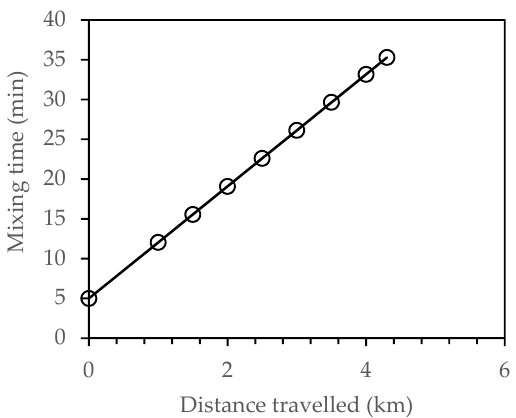
Figure 12. Effect of travel distance (between the backfill plant and the stope to be backfilled) on the variation of mixing time for mixture M02 (data given in Table 2 with l ≤ 4.3 km).